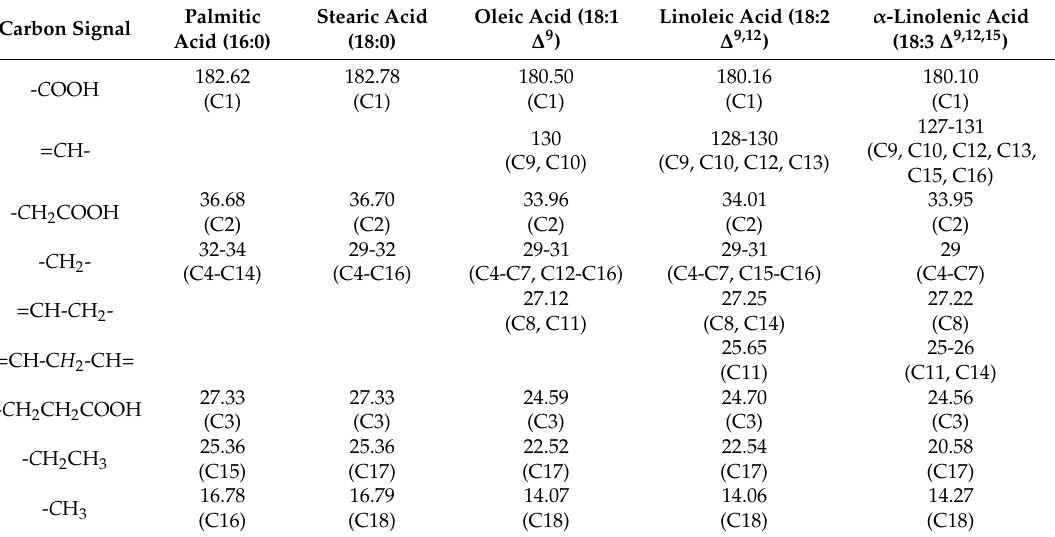
Table 2. 13 C chemical shifts of fatty acids mainly present in WCO